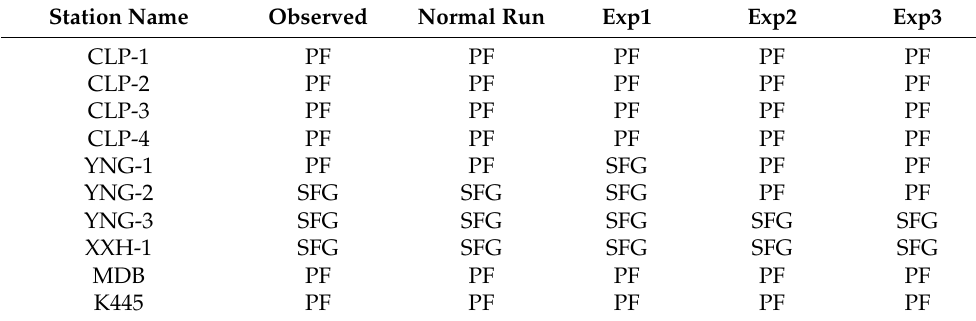
Table 4. Frozen soil types estimated at 10 boreholes in the normal run, exp1, exp2, and exp3.